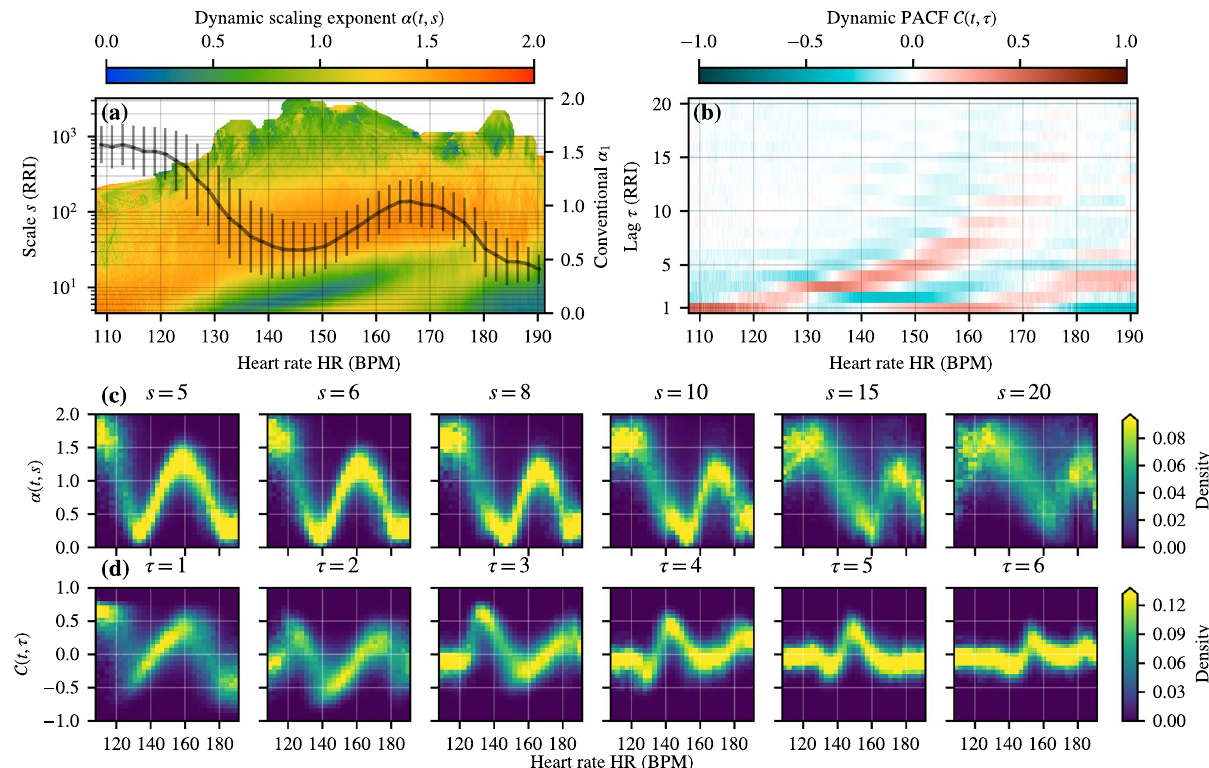
Figure 4. Aggregate beat-to-beat (RR) interval correlations for all the exercises of one subject (T07) in group T. ( a ) Average values for α( t , s ) for each scale s (y-axis) and binned HR (x-axis). The solid line shows the conventional short-range α 1 . ( b ) Average values for C ( t , τ) for each lag τ (y-axis) and binned HR (x-axis). ( c ) Probability density histogram for α( t , s ) for different scales s as a function of the HR. ( d ) Probability density histogram for C ( t , τ) for different lags τ as a function of the HR. Note that the probability densities are separately normalized for each HR bin. For details on data processing, please see the caption of Fig.